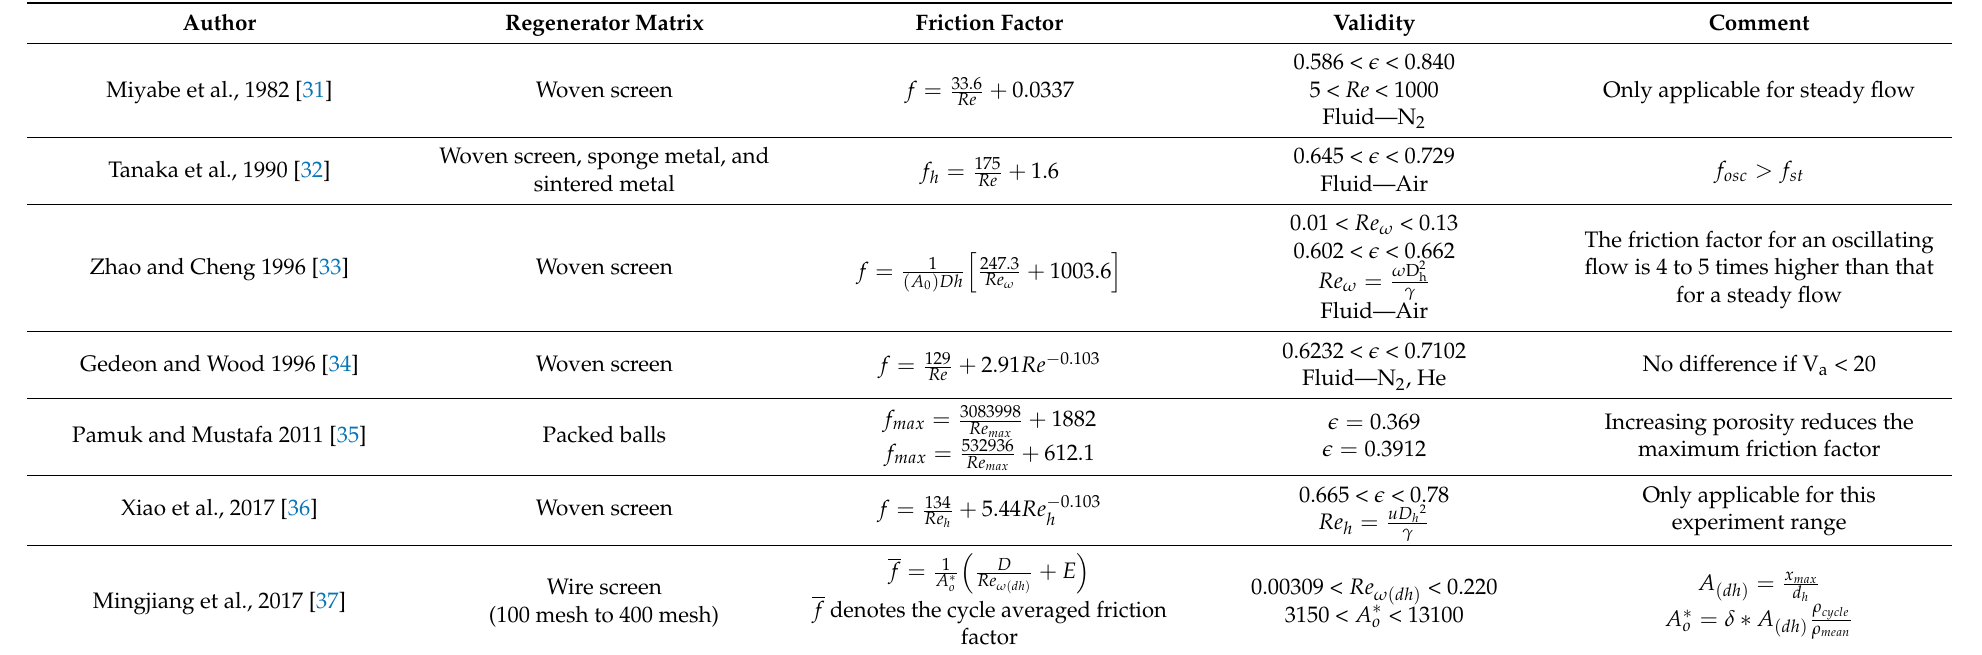
Table 1. Friction factor correlation obtained in various